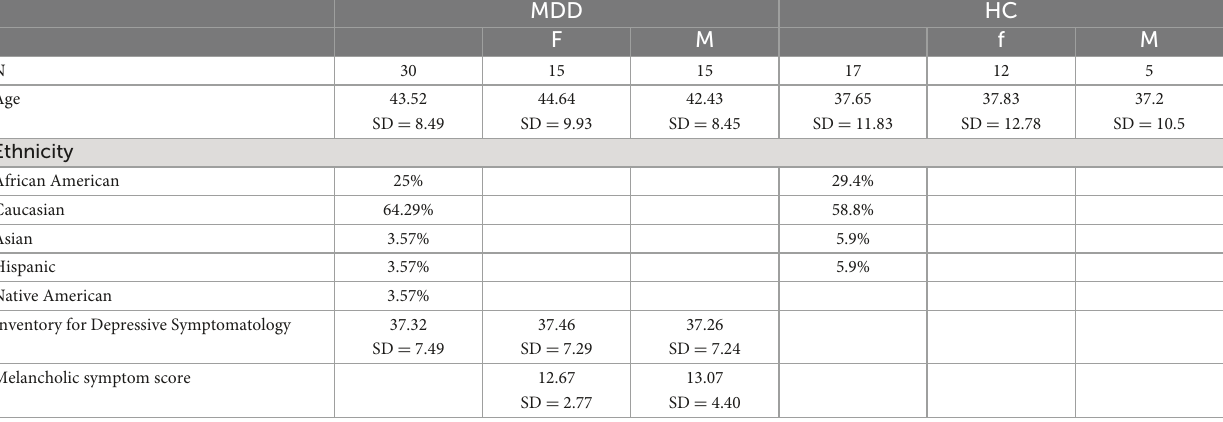
TABLE 1 Demographic and clinical